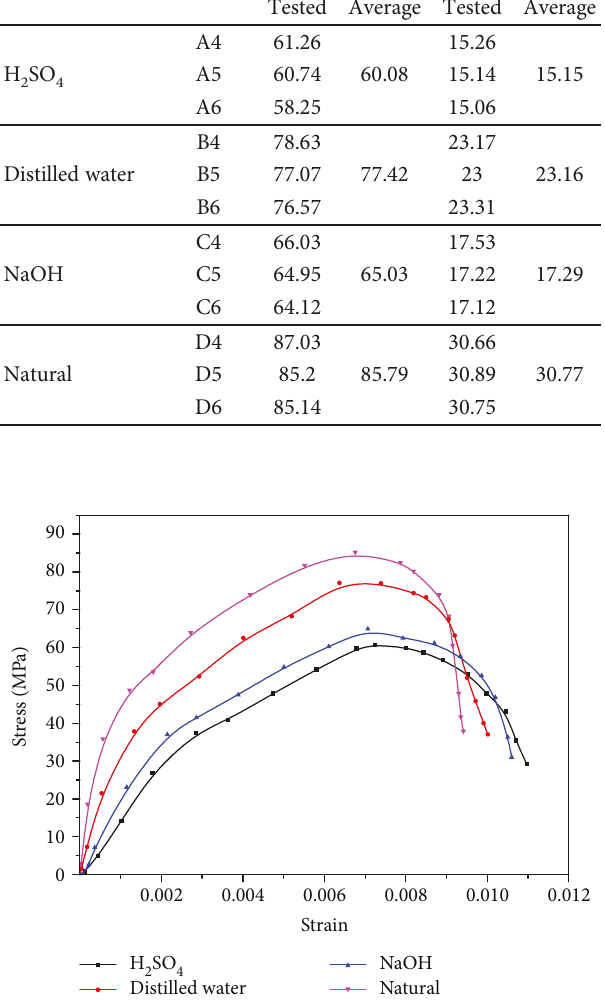
Figure 11: Dynamic stress – strain curves of the sandstone specimens subjected to di ff erent chemical